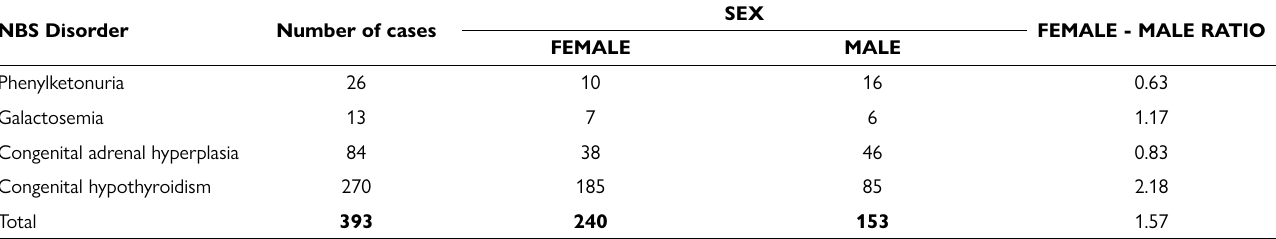
Table 1. Cases by the Neonatal Screening Program classified by type of disorder and sex.